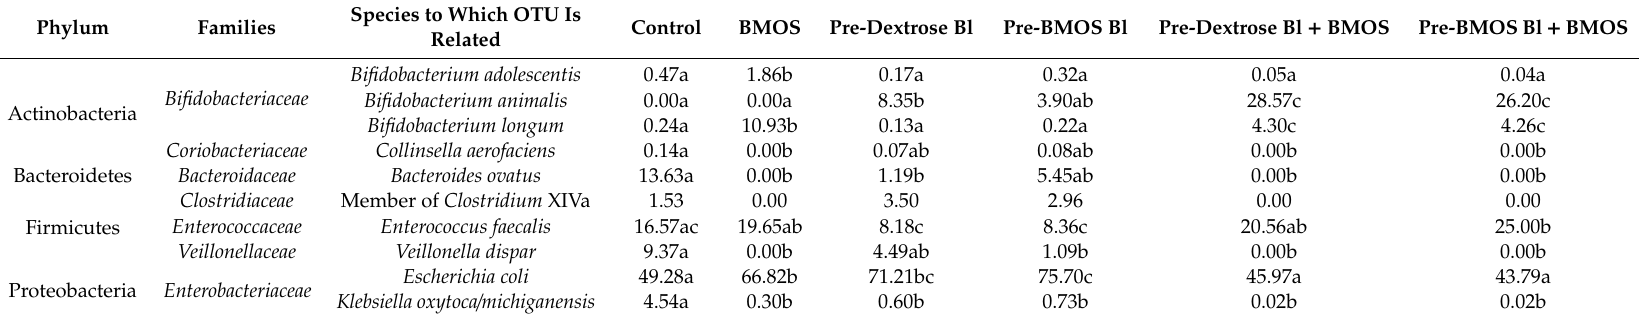
Table 2. Relative average abundance (%) of di ff erent microbial Operational Taxonomic Units (OTU) upon a 48 h fermentation of 5 g / L BMOS containing 1.5 × 10 7 CFU / mL of B. lactis previously grown on either Dextrose (Pre-Dextrose Bl + BMOS, n = 3) or BMOS (Pre-BMOS Bl + BMOS, n = 3), by an infant fecal microbiota of Donor 8, versus their respective controls (Control, Pre-Dextrose Bl and Pre-BMOS Bl, n =